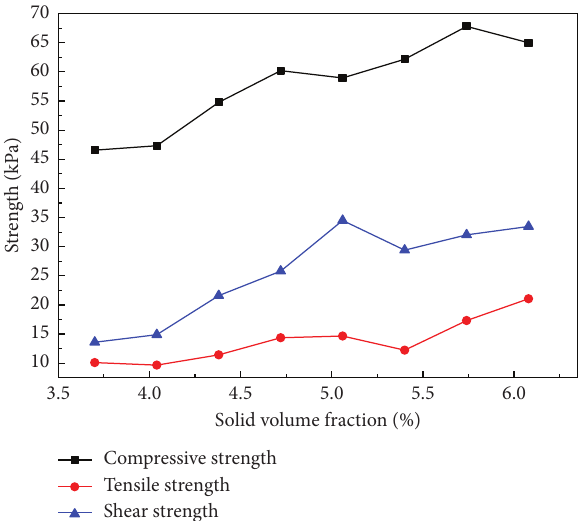
Figure 12: Testing data of the mechanical properties of RWB (mean diameter � 10.5 μ